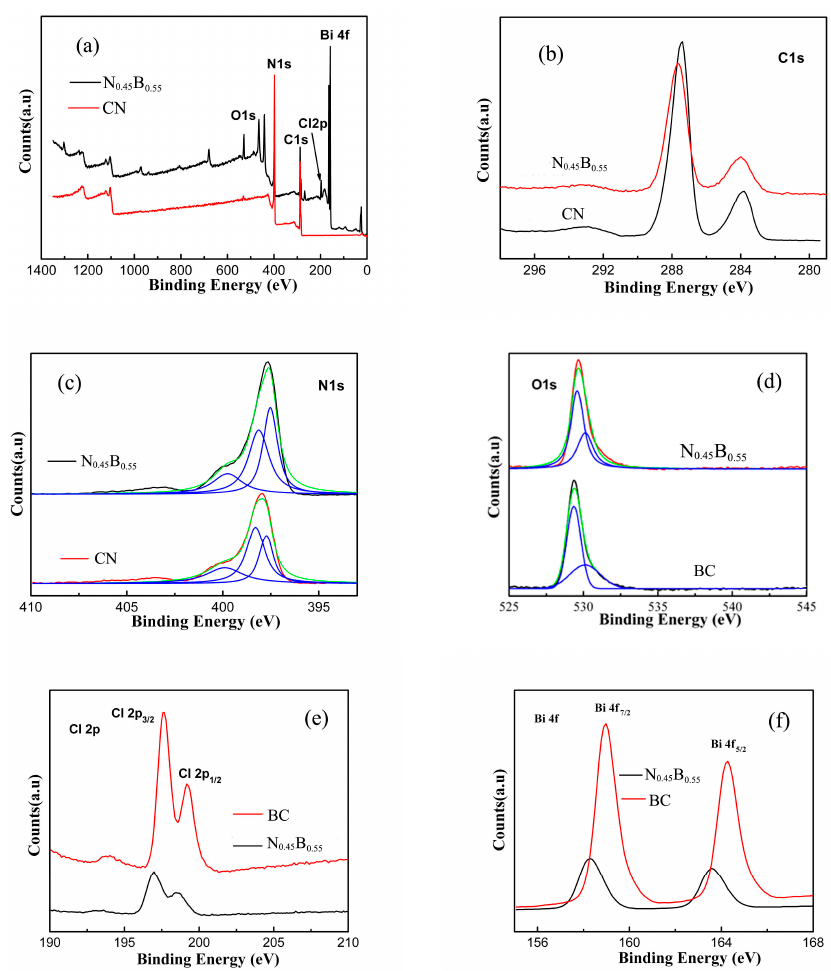
Figure 2. XPS spectra of the as-obtained BiOCl, g-C 3 N 4 and N 0.45 B 0.55 samples: ( a ) survey; ( b ) C1s; ( c ) N1s; ( d ) O1s; ( e ) Cl 2p; and ( f ) Bi 4f.